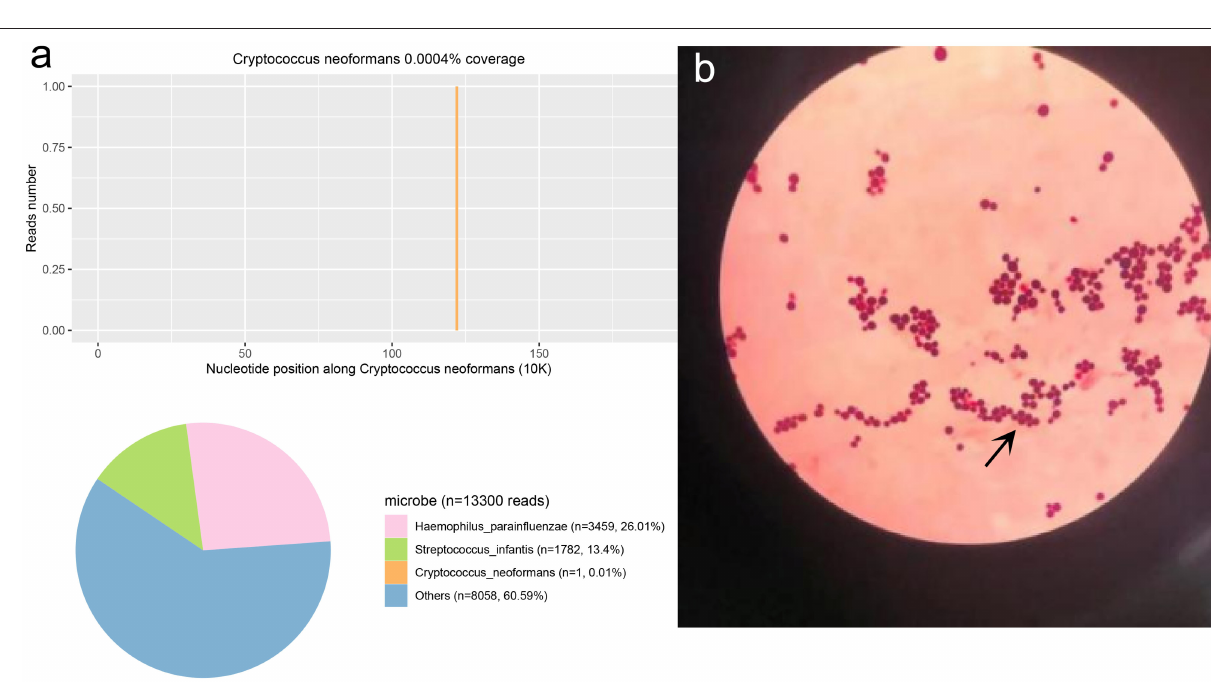
(BALF) showed a medium amount of squamous epithelium, bronchial columnar epithelial cells, and a small number of neutrophils, but no cancer cells. Microscopic examination